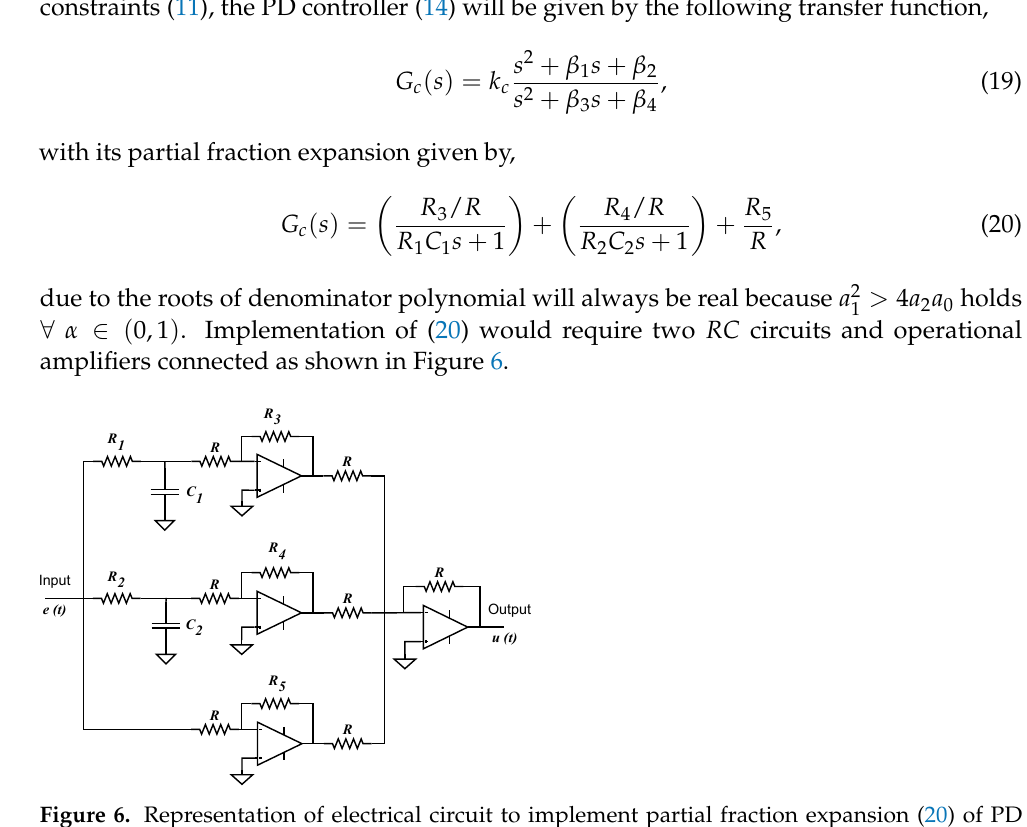
Figure 6. Representation of electrical circuit to implement partial fraction expansion (20) of PD controller